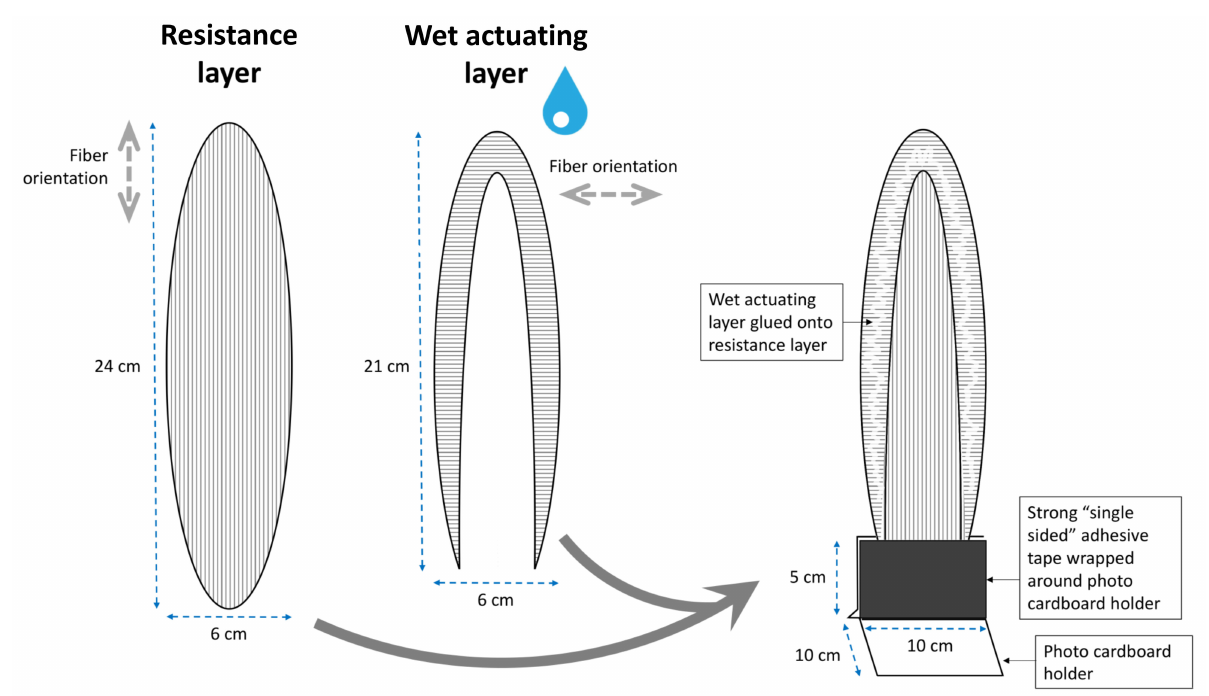
Figure 5. Exemplary construction manual for the abstraction of the deformation of the petal of the lily ( L. spec.) and its transfer into a paper-based self-actuated compliant system. The fiber orientations of the dry RL and wet AL are indicated (gray dashed arrows). Details are provided in the main